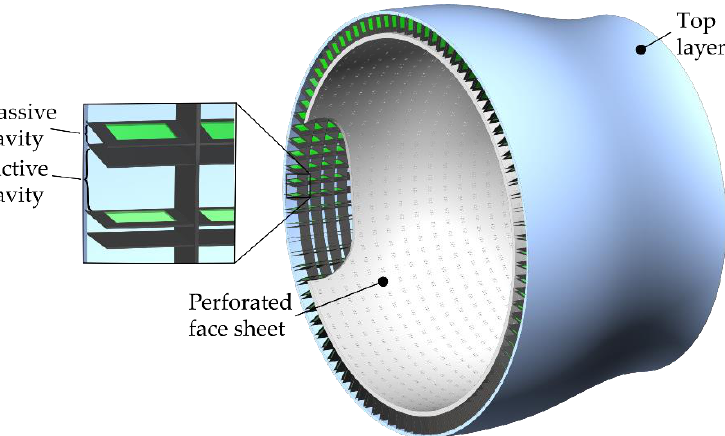
Figure 16. Design study of a curved FHR liner with the perforated face sheet including active and passive cavities, the covering face sheet and the strip slotted cavity structure.